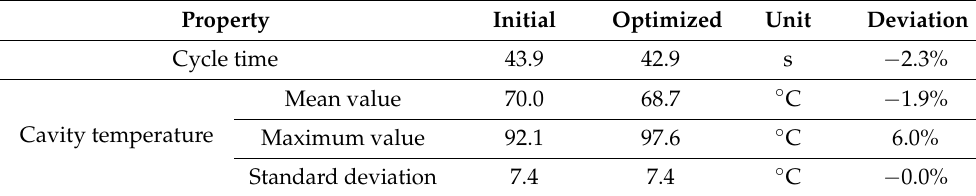
Table 6. Comparison of the simulation results of the initial configuration and the optimized solution.